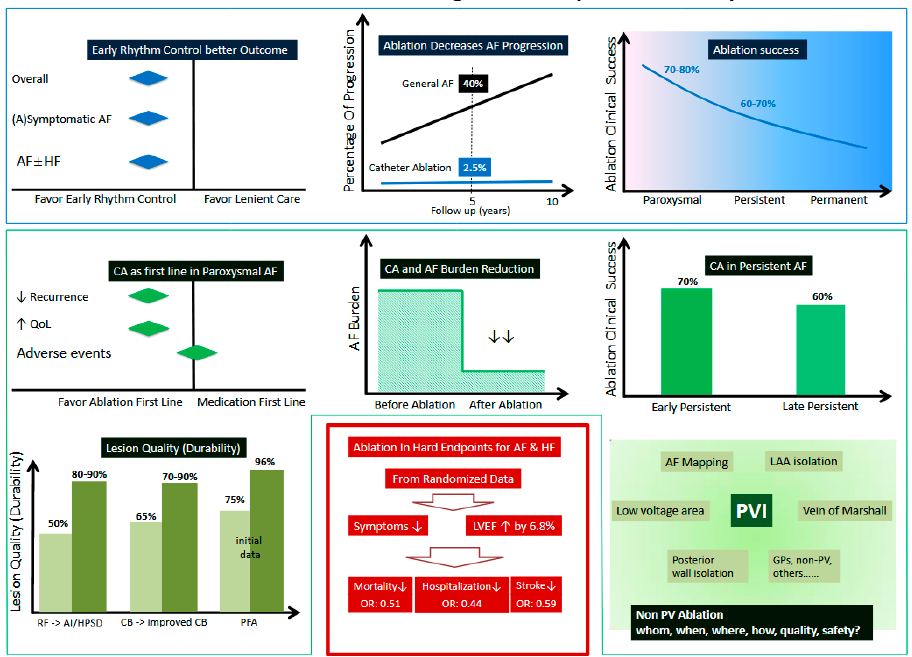
Figure 8. Graphic Summary Chen et